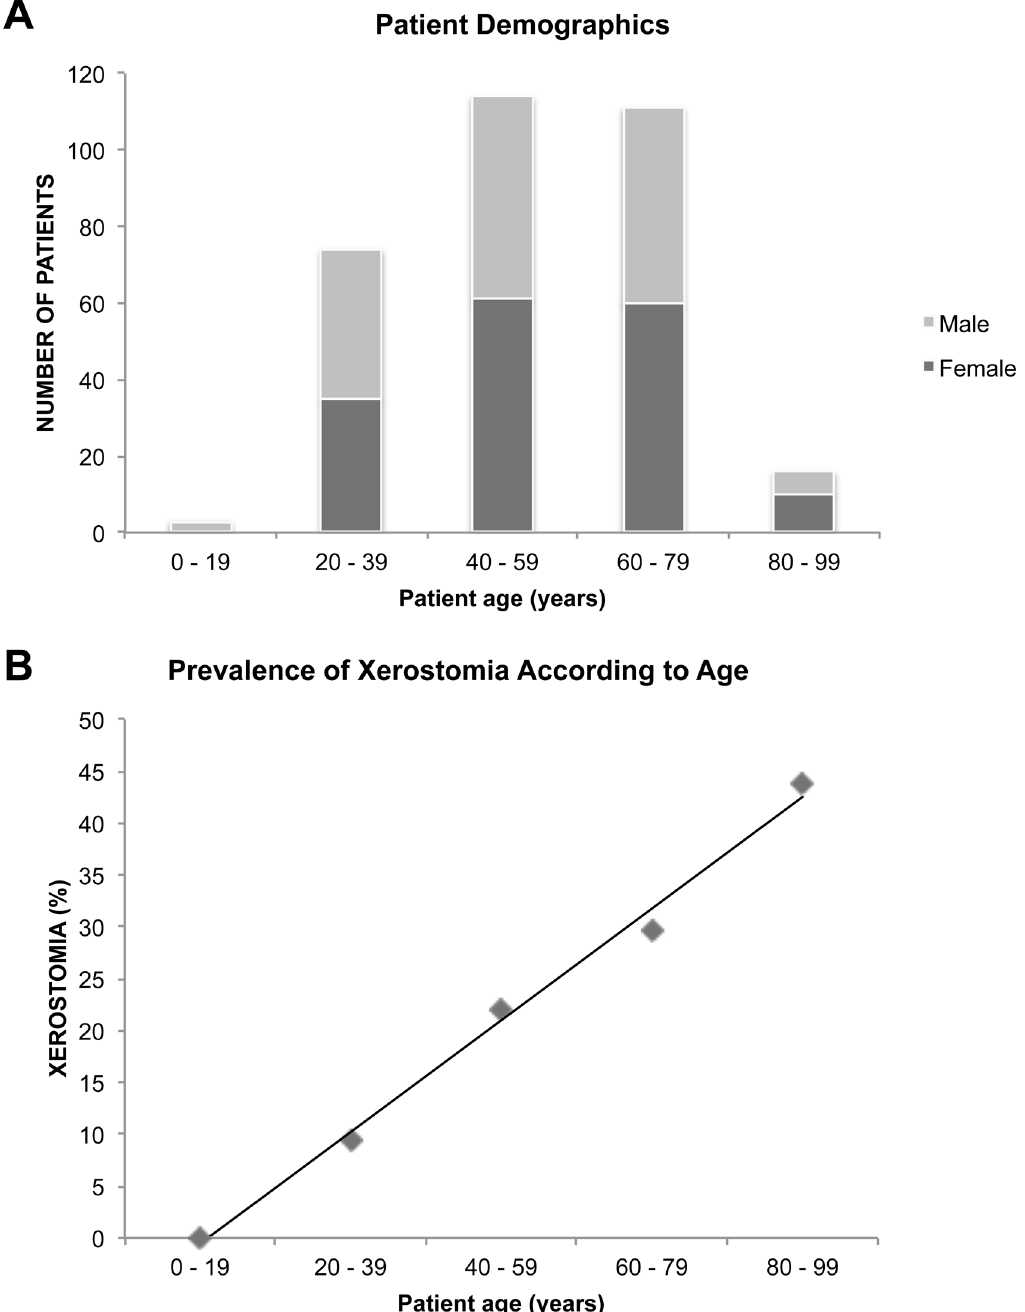
Fig 1. Patient demographics. ( A ) Bar graph showing the age and sex distribution among 318 patients with dry eye disease consecutively included in the study. ( B ) Scatterplot showing the prevalence of xerostomia according to age in 318 dry eye disease